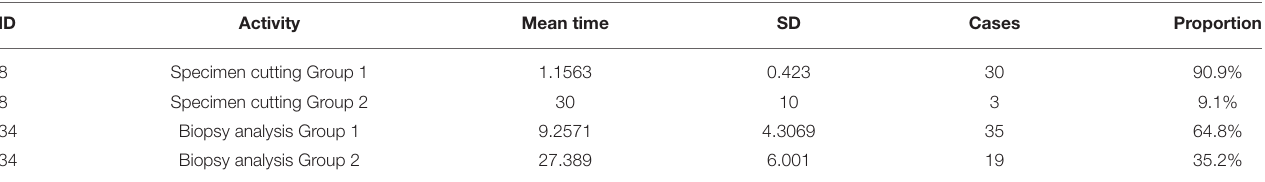
TABLE 3 | Proportion of hours to simulate for the combination of biopsy cutting and analysis.